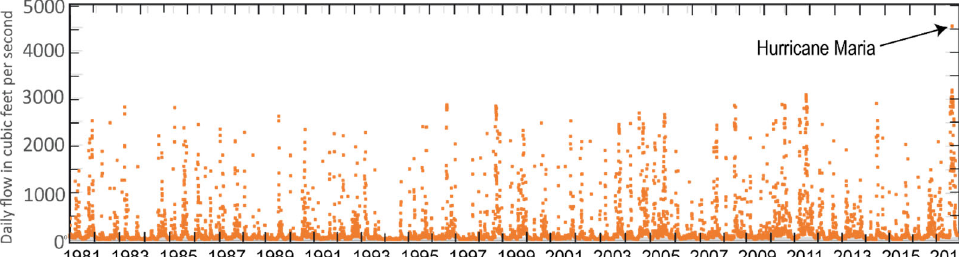
Figure 15. Simulated coastal flow in the western coastal area of the municipality of Barceloneta.